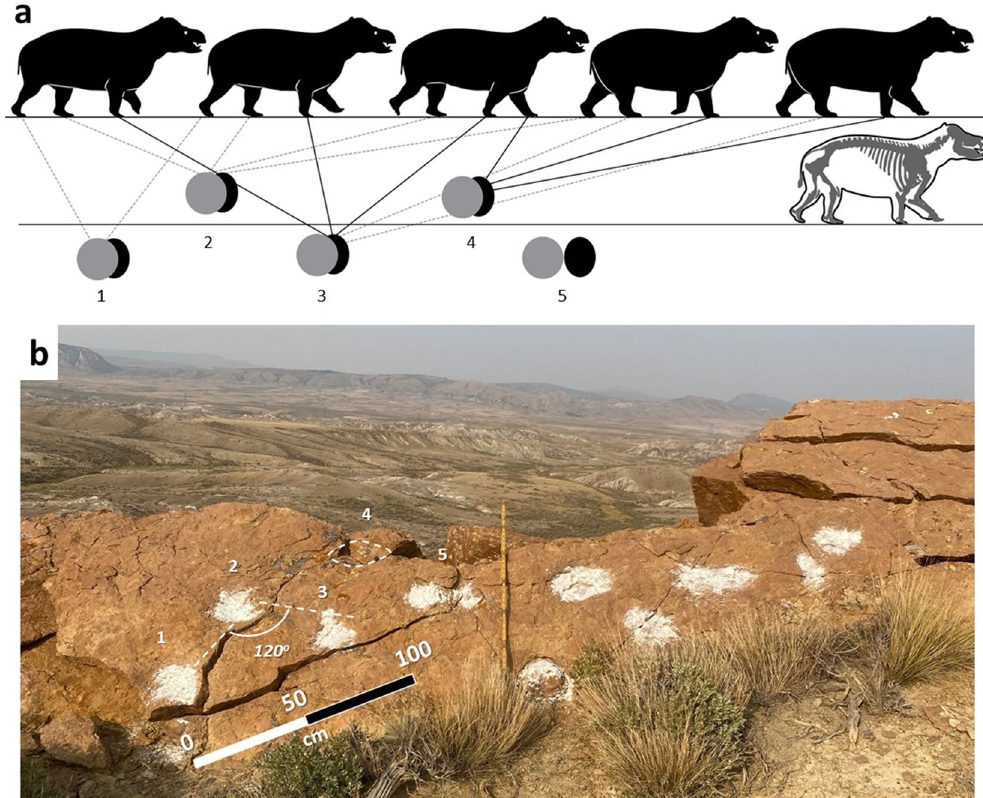
Figure 7. Example of wide gauge trackway and candidate track maker. ( a ) Walk cycle of Coryphodon inferred from trackway showing slow, direct register to understep walk. Biomechanical reconstruction was constrained by skeletal elements preserved for C. radians (modified from original 18 ) as depicted at lower left; ( b ) Photograph of trackway from which a is modeled (view to the northeast). Scale bar is 1 m. Drawings made by A F-J W in Adobe Illustrator 2021 (version 25.2.1, https:// www. adobe. com/ produ cts/ illus trator. html). Photographs by A F-J W and compiled in Microsoft PowerPoint (version 16.0.13801.20266, https:// www. micro soft. com/ en- us/ micro soft- 365/ power point).